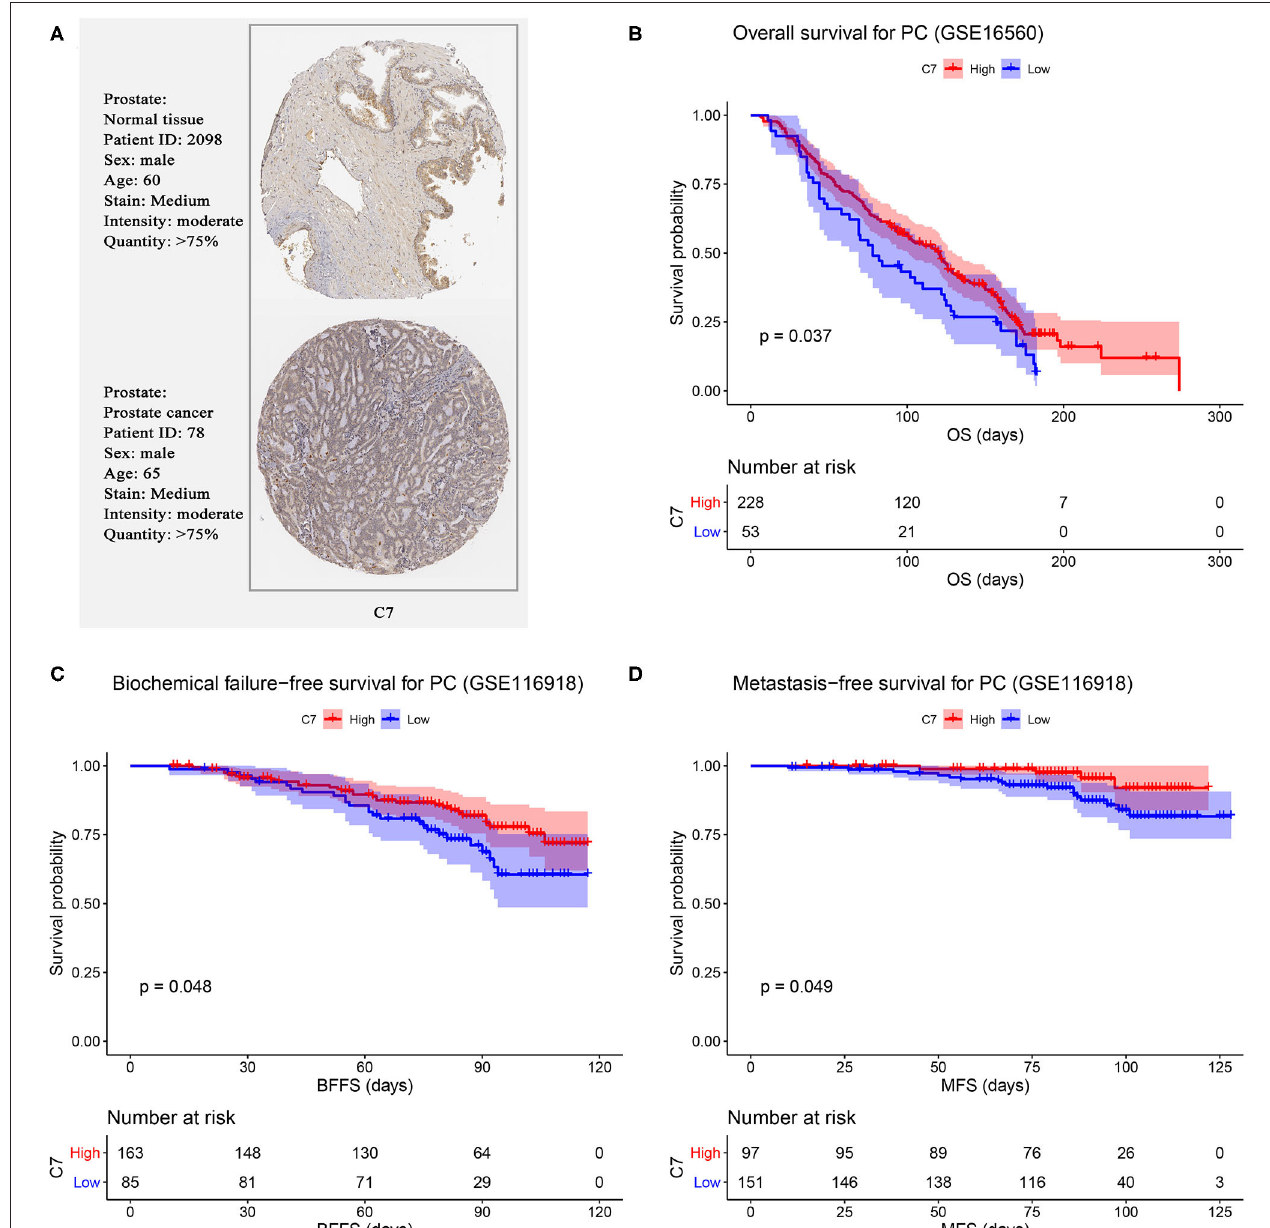
FIGURE 6 | (A) Validation of hub genes in translational level by The Human Protein Atlas database (IHC). Survival analysis of the association between C7 expression and overall survival (B) , biochemical failure free survival (C) , and metastasis free survival (D) time in PC.